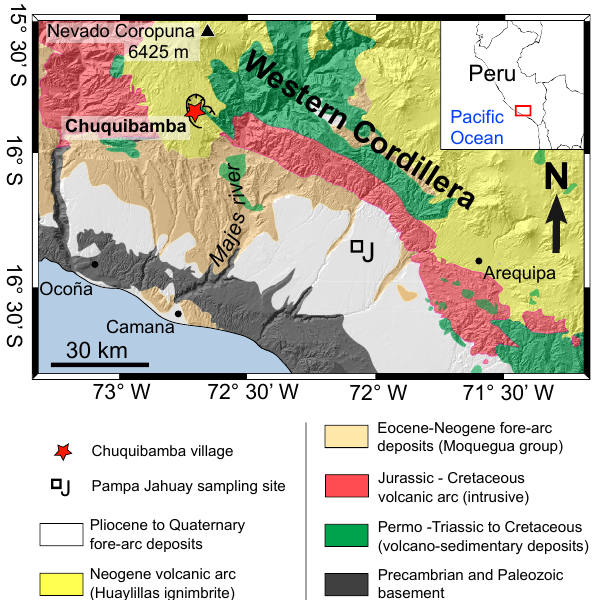
Figure 1. Simplified geological map of South Peru (modified from Roperch et al., 2006; INGEMMET, 2001), showing the village of Chuquibamba (red star), the destabilization zone and the Pampa Jahuay sampling site (J). Coordinates are given in WGS 84 lon- gitude and latitude (degrees). Inset shows the study area location within Peru and a part of South America.